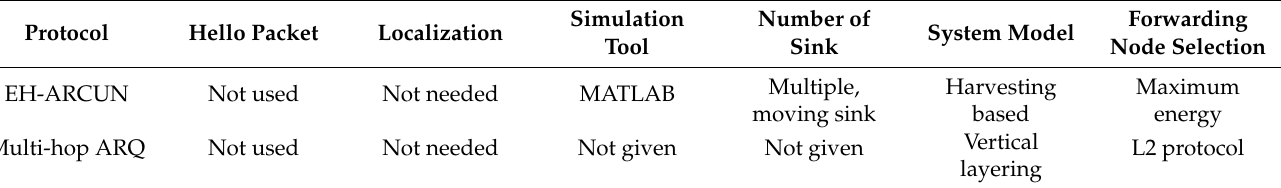
Table 4. Comparison of hybrid routing